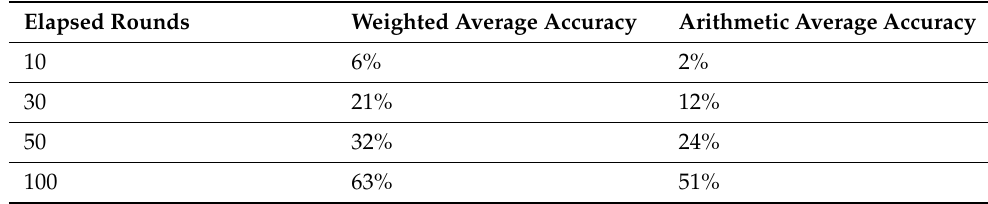
Table 6. Results obtained from 8 clients (two clients with 7.5%, two with 12.5%, two with 30%, and two with 0.0002%) with the more complex CIFAR100